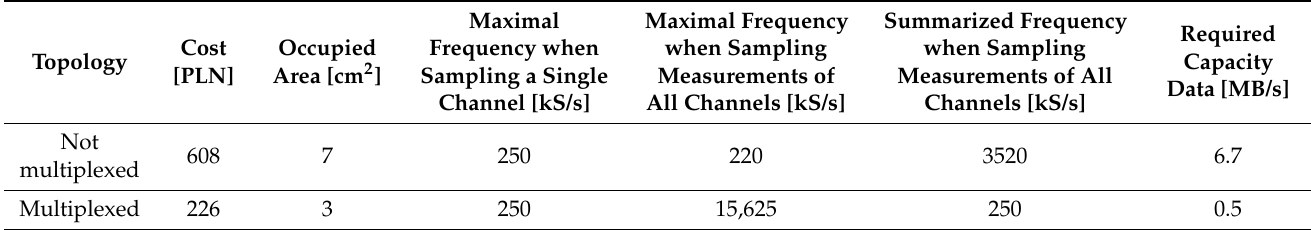
Table 1. Summary of the results of the topology analysis of the analog part of the project.